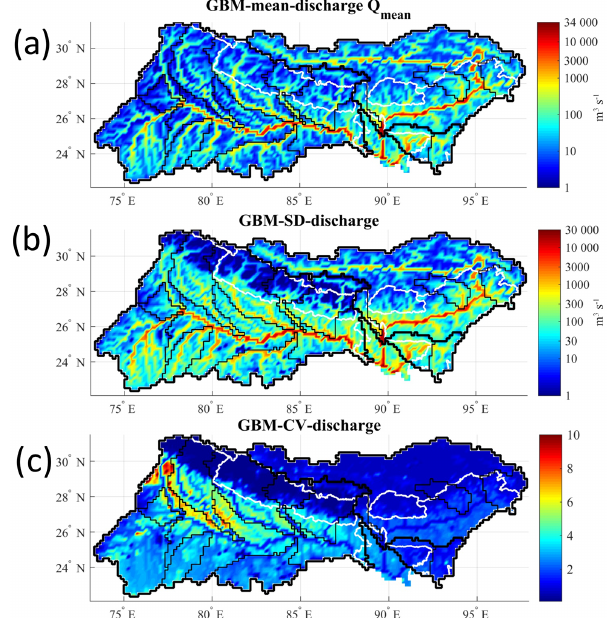
Figure 8. Maps of (a) the mean, (b) SD, and (c) CV of the simulated discharge for